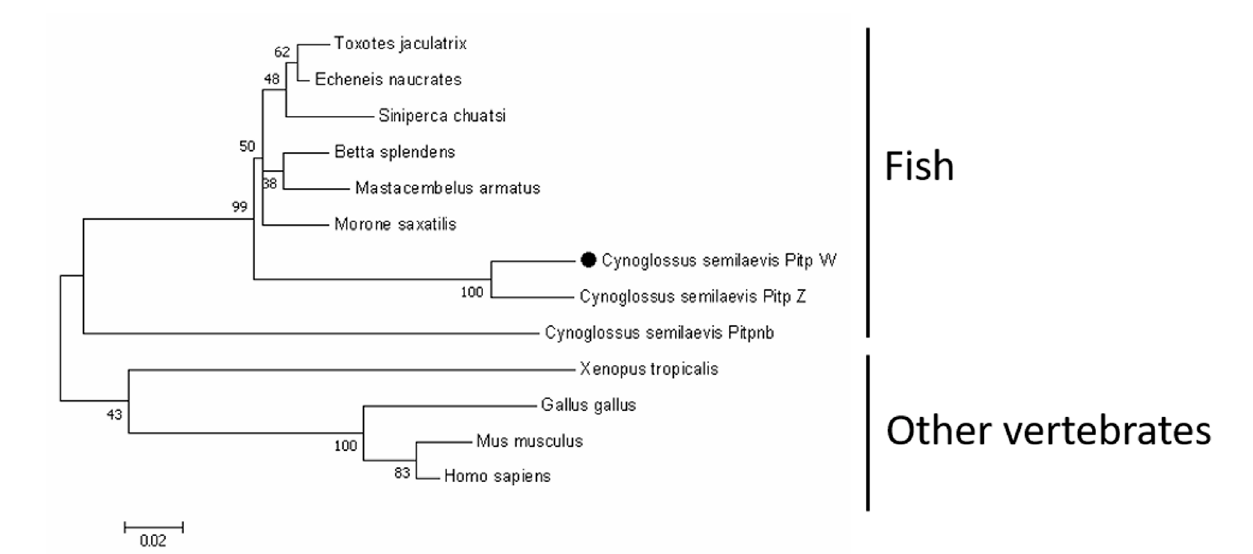
FIGURE 2 | Phylogenetic analysis of Pitp β from C. semilaevis and other vertebrates. Numbers at nodes represent NJ bootstrap values. The GenBank accession numbers were as follows: Cynoglossus semilaevis Pitp_w, XP_008333459.1; Cynoglossus semilaevis Pitp_z, XP_008334298.1; Cynoglossus semilaevis Pitpnb, XP_008323858.1; Morone saxatilis , XP_035514806.1; Betta splendens , XP_029019228.1; Toxotes jaculatrix , XP_040898022.1; Siniperca chuatsi , XP_044053196.1; Echeneis naucrates , XP_029366369.1; Mastacembelus armatus , XP_026177048.1; Xenopus tropicalis , NP_989122.1; Gallus gallus , NP_001383302.1; Mus musculus , AAA87593.1; and Homo sapiens ,